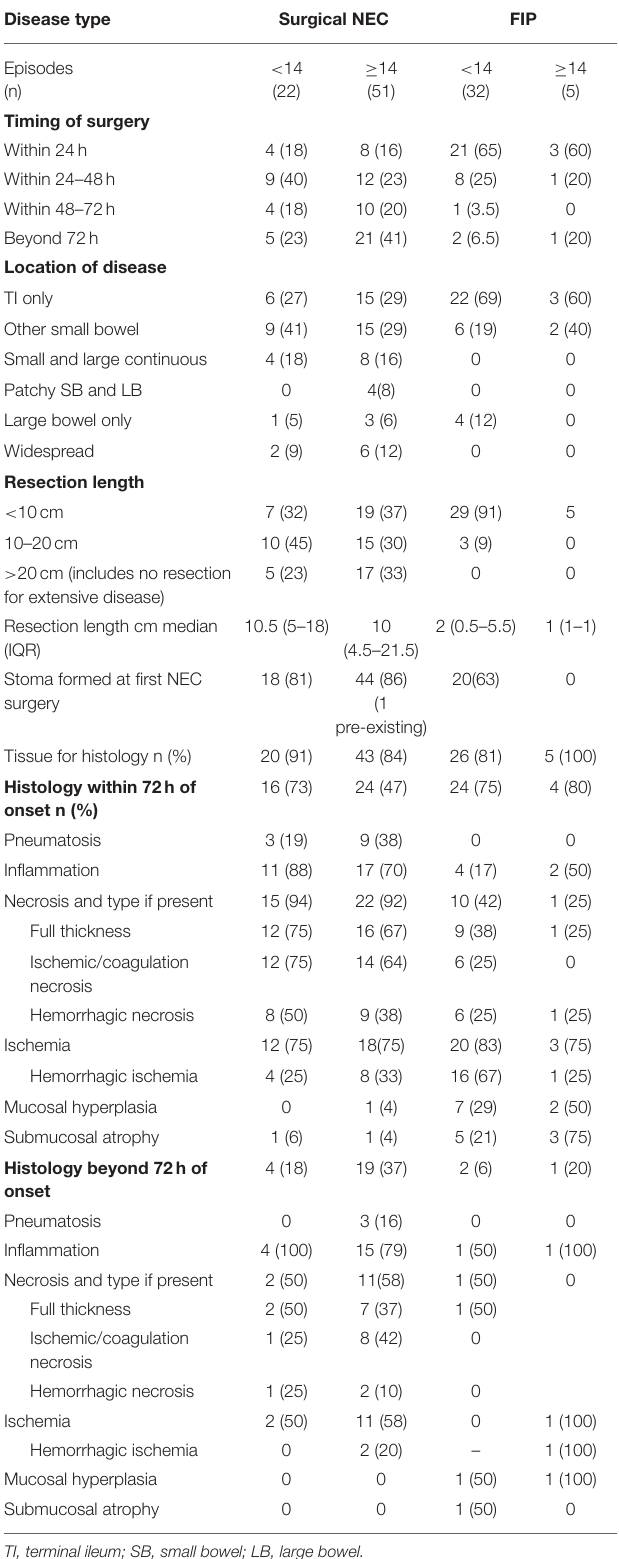
TABLE 4 | Surgical and histological